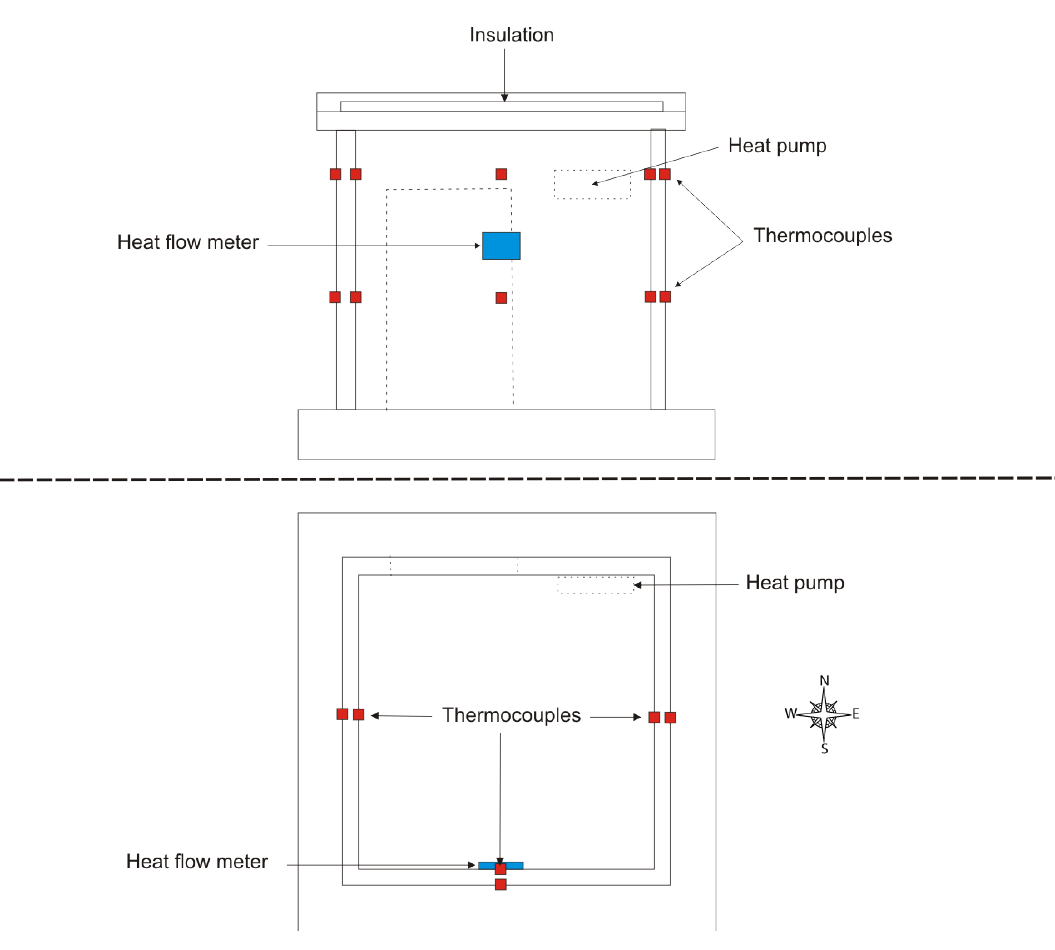
Figure 2. Schematic of the sensors location in the